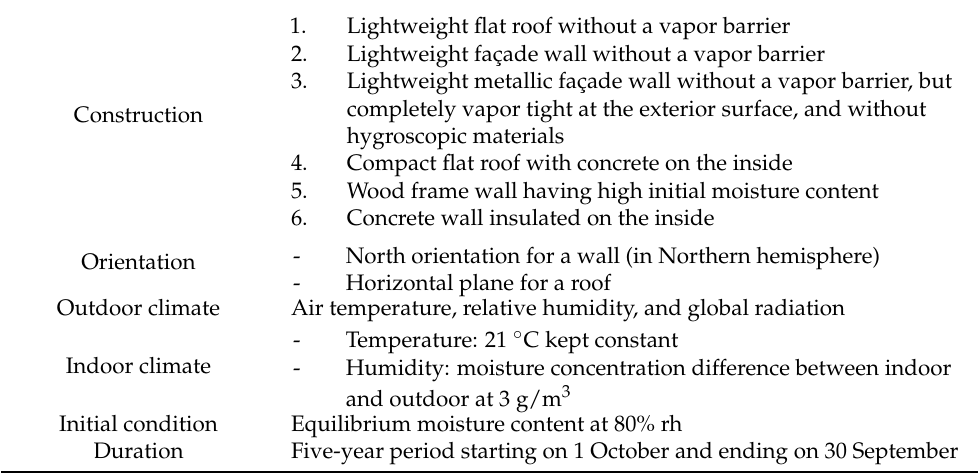
Table 2. Input data for hygrothermal simulations used in Geving